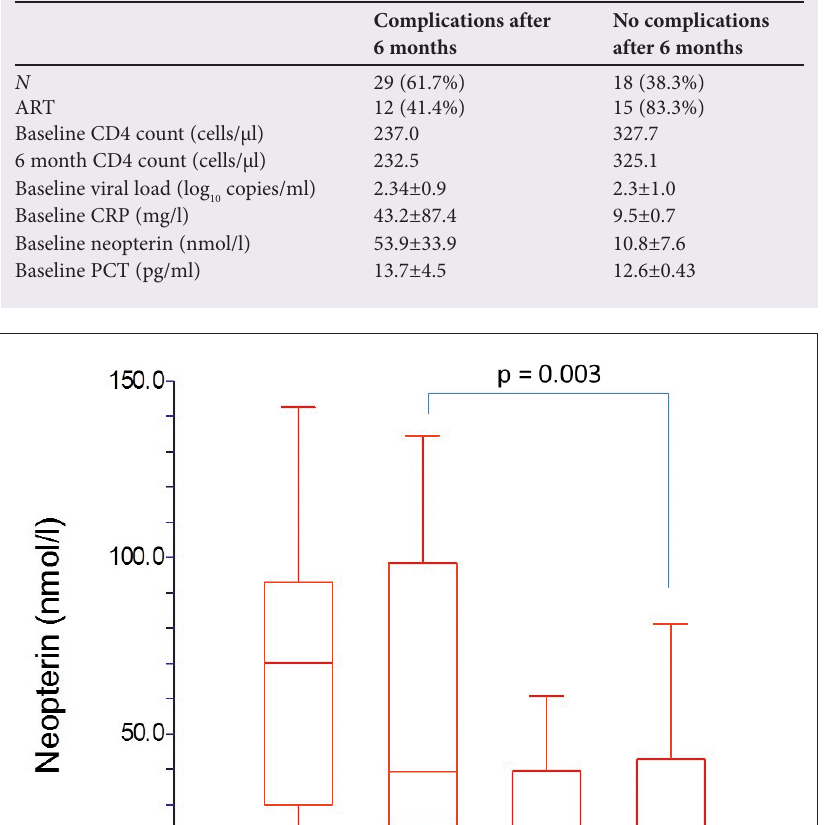
Table 3. Comparisons for patients who were followed up after 6